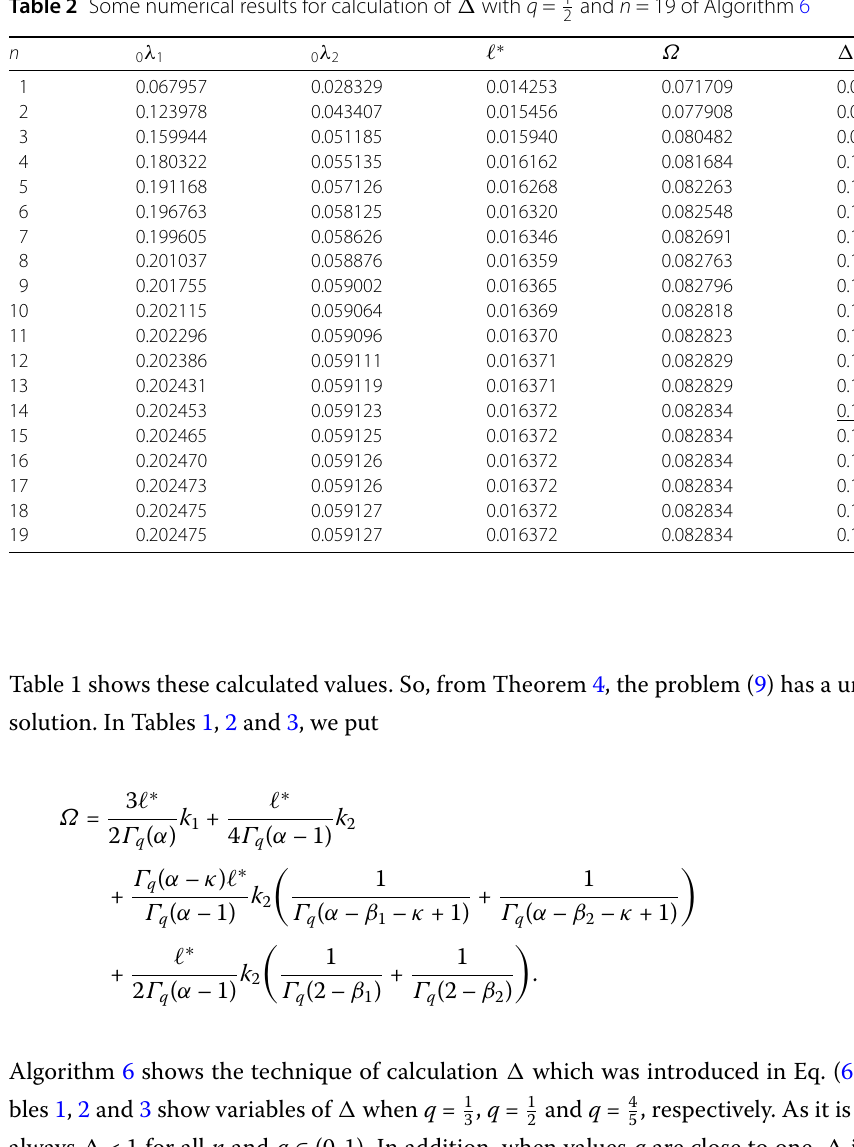
Table 2 Some numerical results for calculation of (cid:13) with q = 1